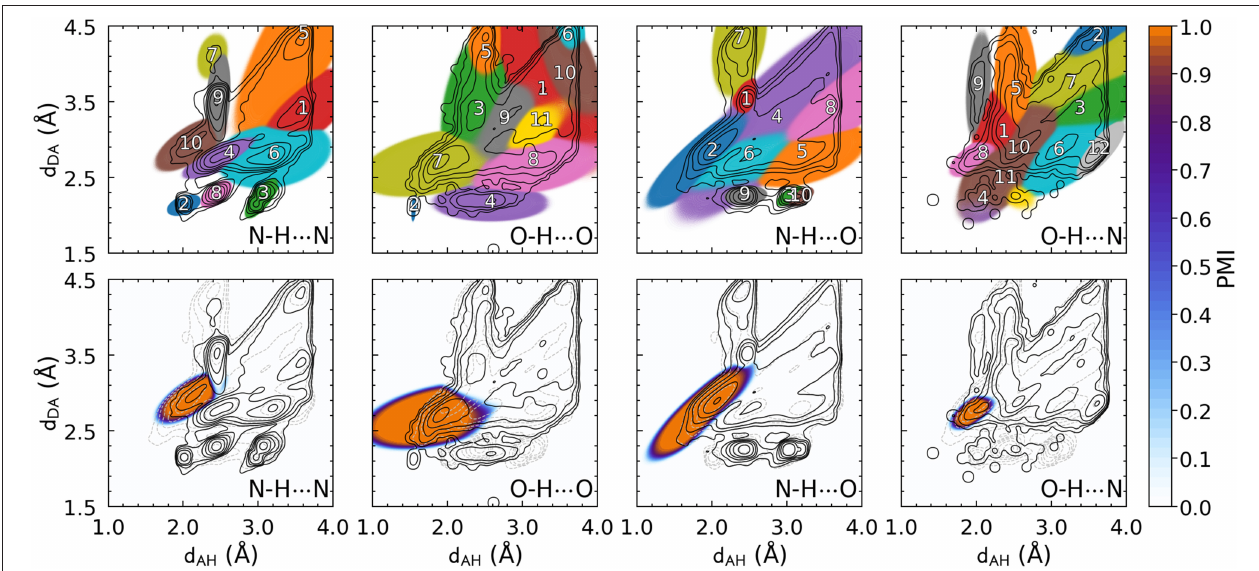
FIGURE 3 | The top panels represent all the clusters identified by PAMM. Clusters are numbered in an arbitrary order, and the colors reflect the cluster that is dominant in each region, as determined by its corresponding PMI [as defined in Equation (1), computed with ζ = 10 − 5 ]. Bottom panels highlights the PMI of the cluster associated with the hydrogen bond.